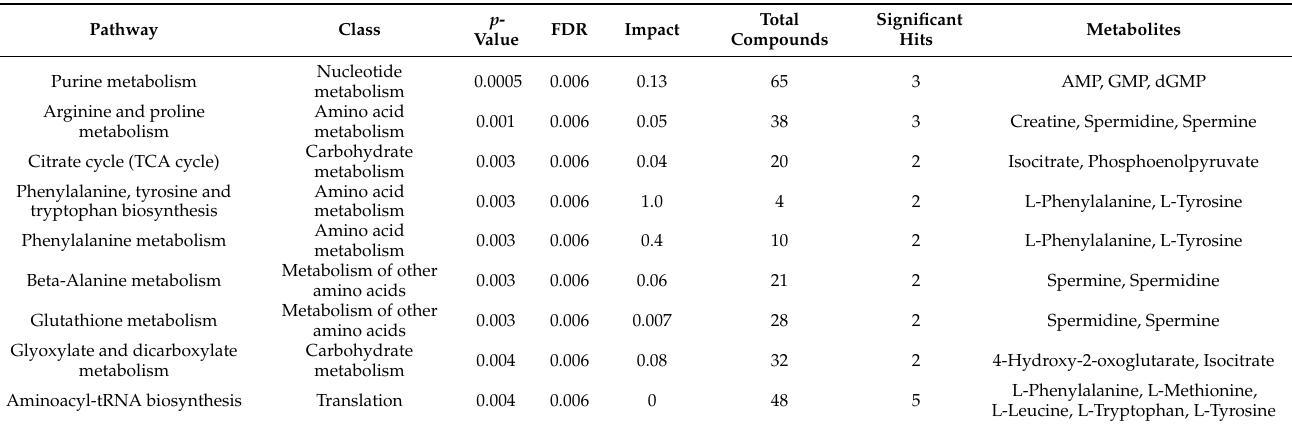
Table 2. Metabolic pathways altered with postnatal